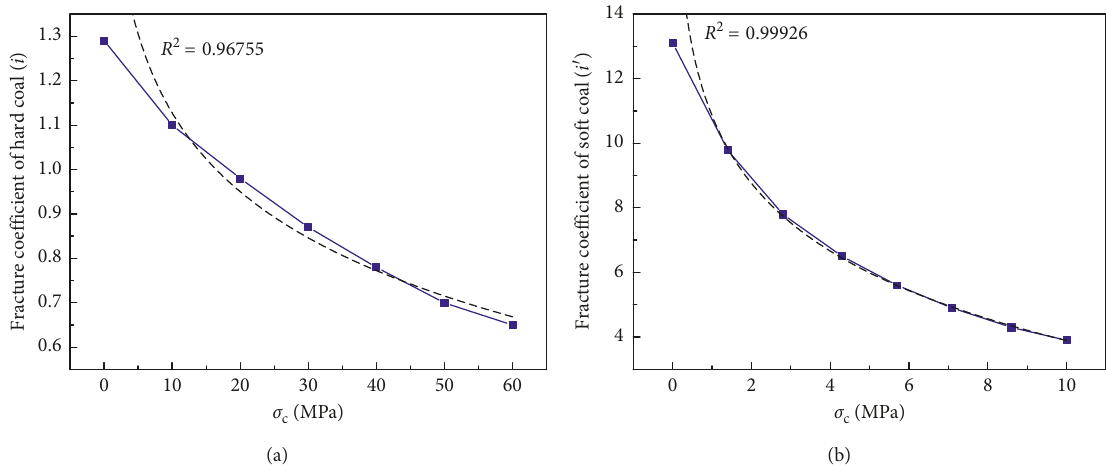
Figure 2: Relationship between function coefficients of hard and soft coal. (a) Hard coal failure factor ( i ) function in hard coal gangue. (b) Soft coal fracture factor ( i ) function. ′ Table 2: Mechanical parameters of hard layer coal gangue in different layers of top coal. Rock stratum